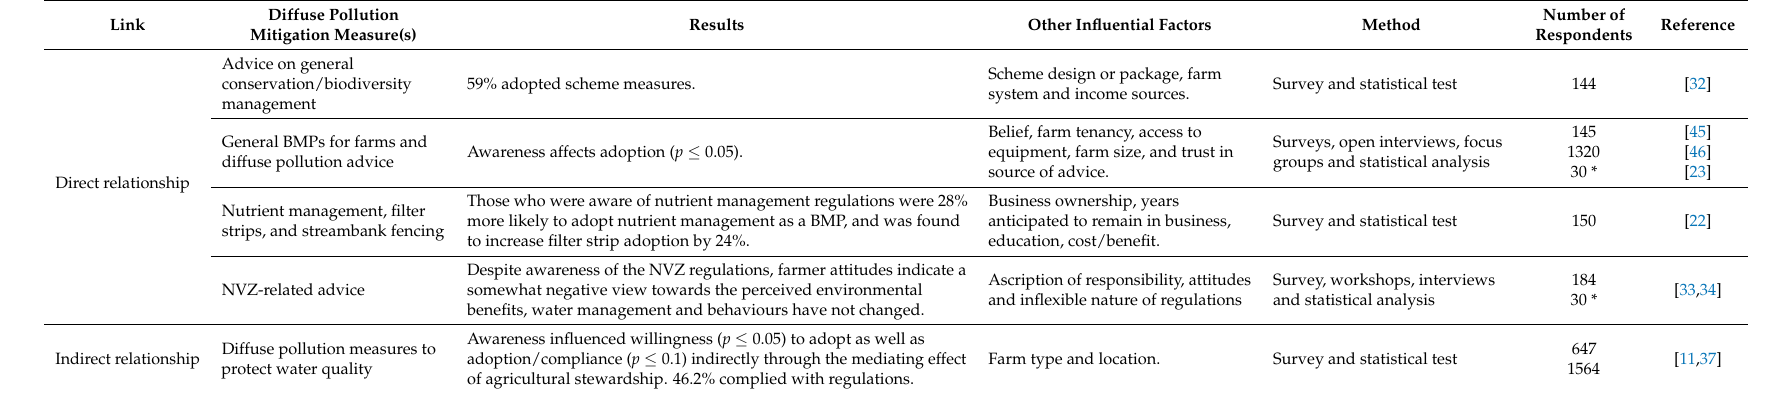
Table 2. Effects of awareness on behaviour via uptake of diffuse pollution mitigation